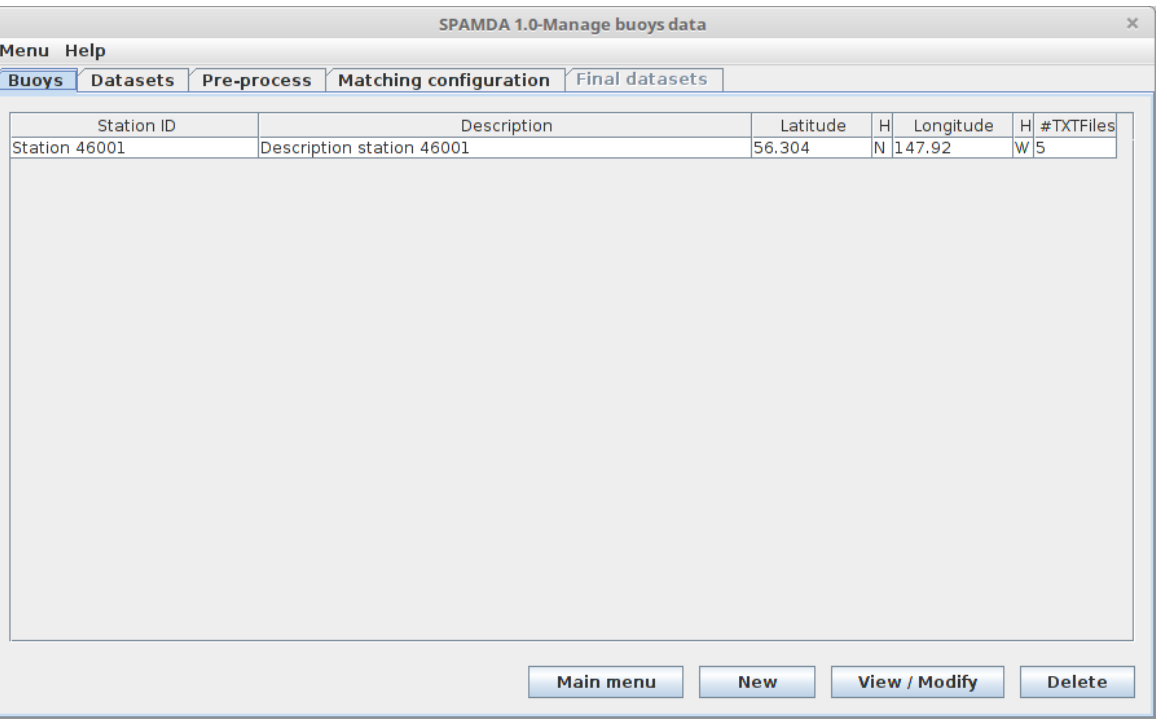
Figure 14. Buoys tab: buoy ID